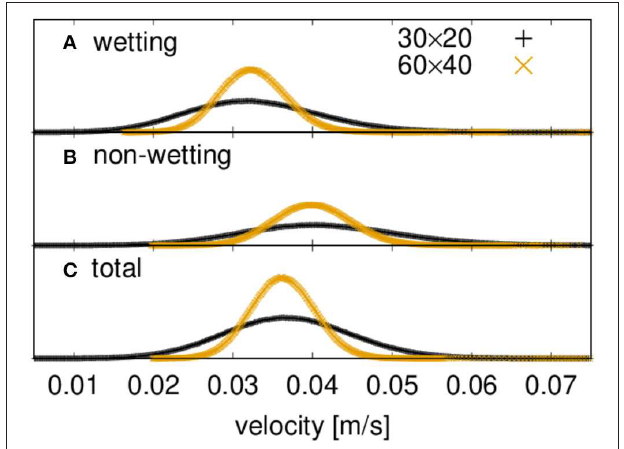
FIGURE 2 | Fluctuations of the volumetric flow Q for case A (see text). The pressure gradient was 100 kPa/m. During the time span shown, 1.3 s, a volume twice the total volume of the network has passed. The inset shows the same quantity over a short time interval.